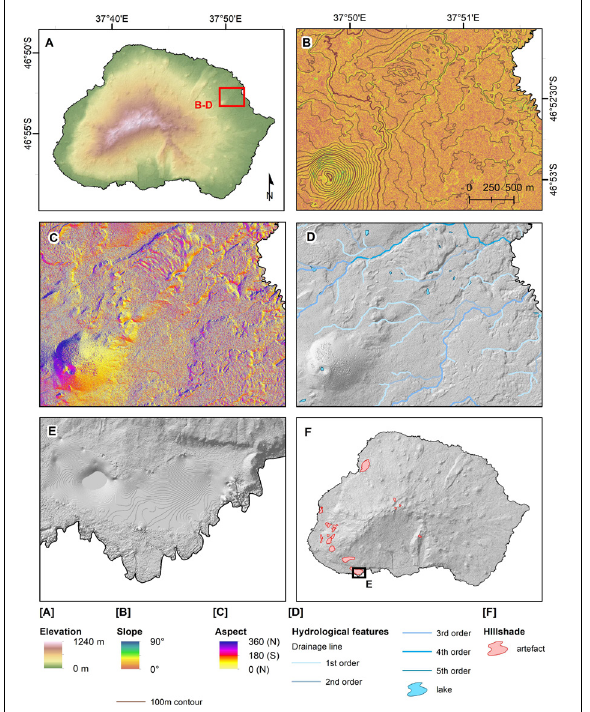
The datasets created in this study from the (A) digital surface model (DSM), using Marion Island’s datasets as an example. (B) A slope raster and contour lines, (C) an aspect raster and (D) hydrological features such as drainage lines and lakes. The hillshade raster has (E) minor artefacts caused by interference in reflectance data by either cloud cover, scoria or snow. (F) Regions on Marion Island where artefacts in the DSM will affect the accuracy of derived geospatial data. Projection: Transverse Mercator